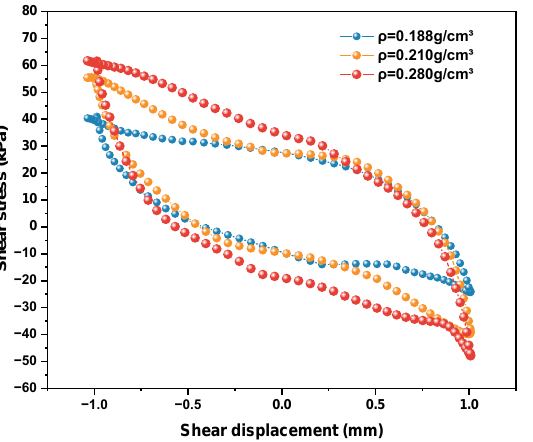
Figure 14. The shear stress – shear displacement relationship curves of different polymer densities.